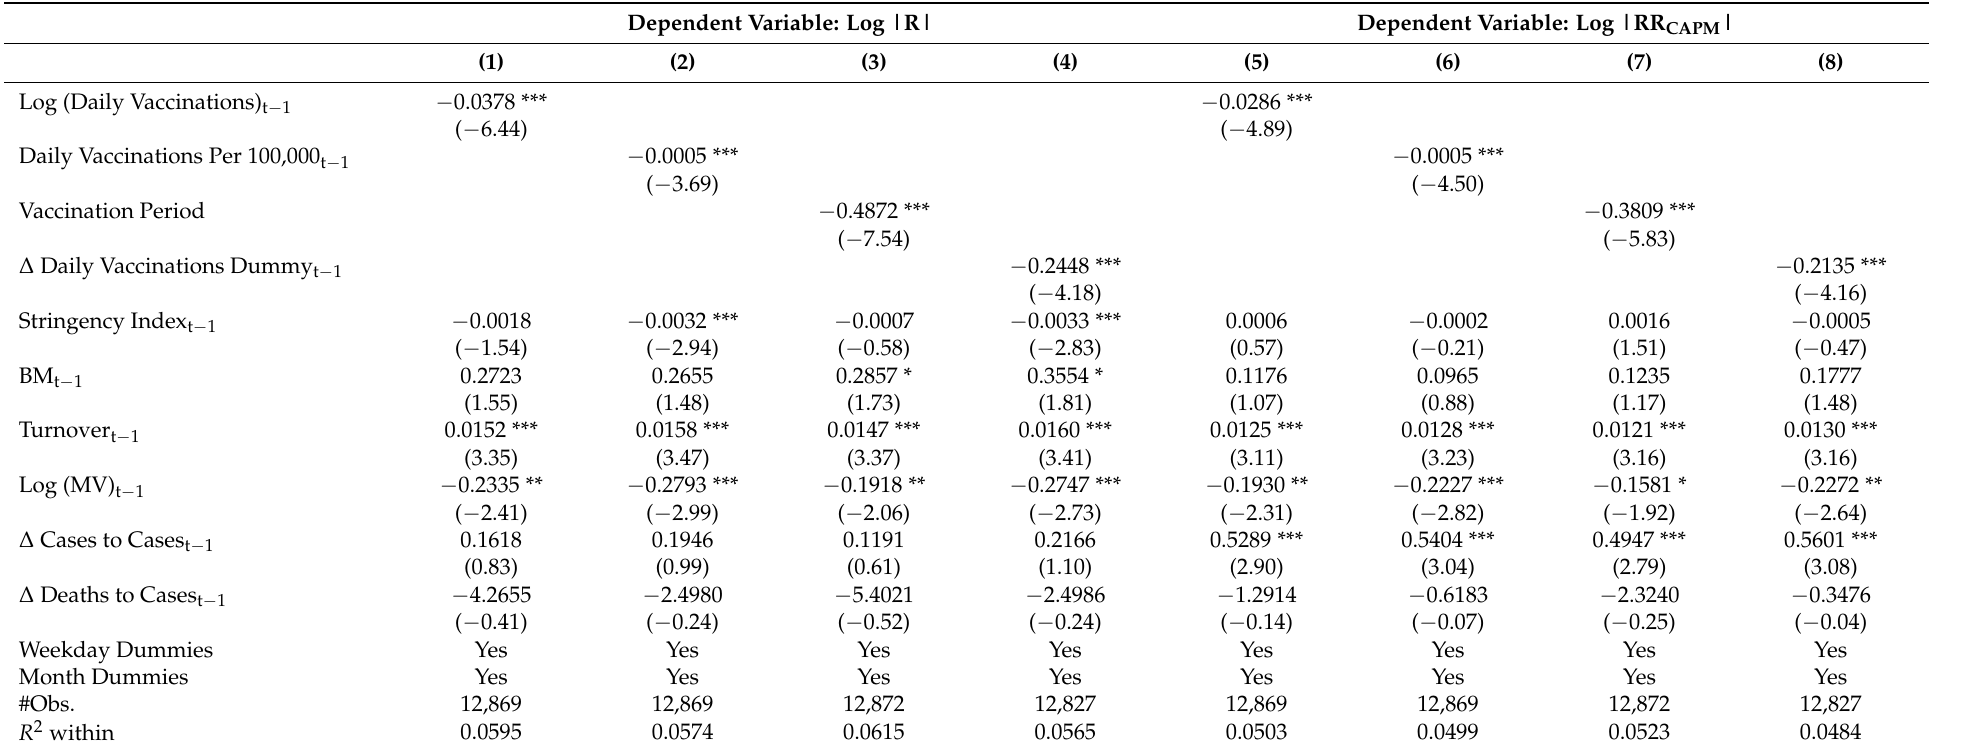
Table 4. Primary